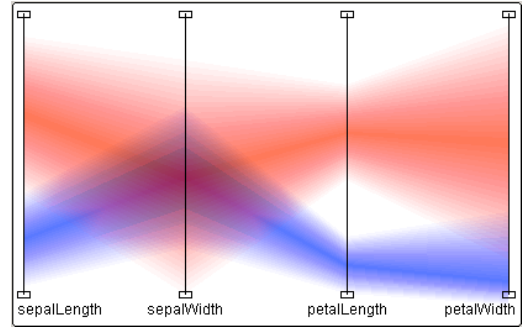
Fig. 14. A visualization of fuzzy rules in parallel coordi-